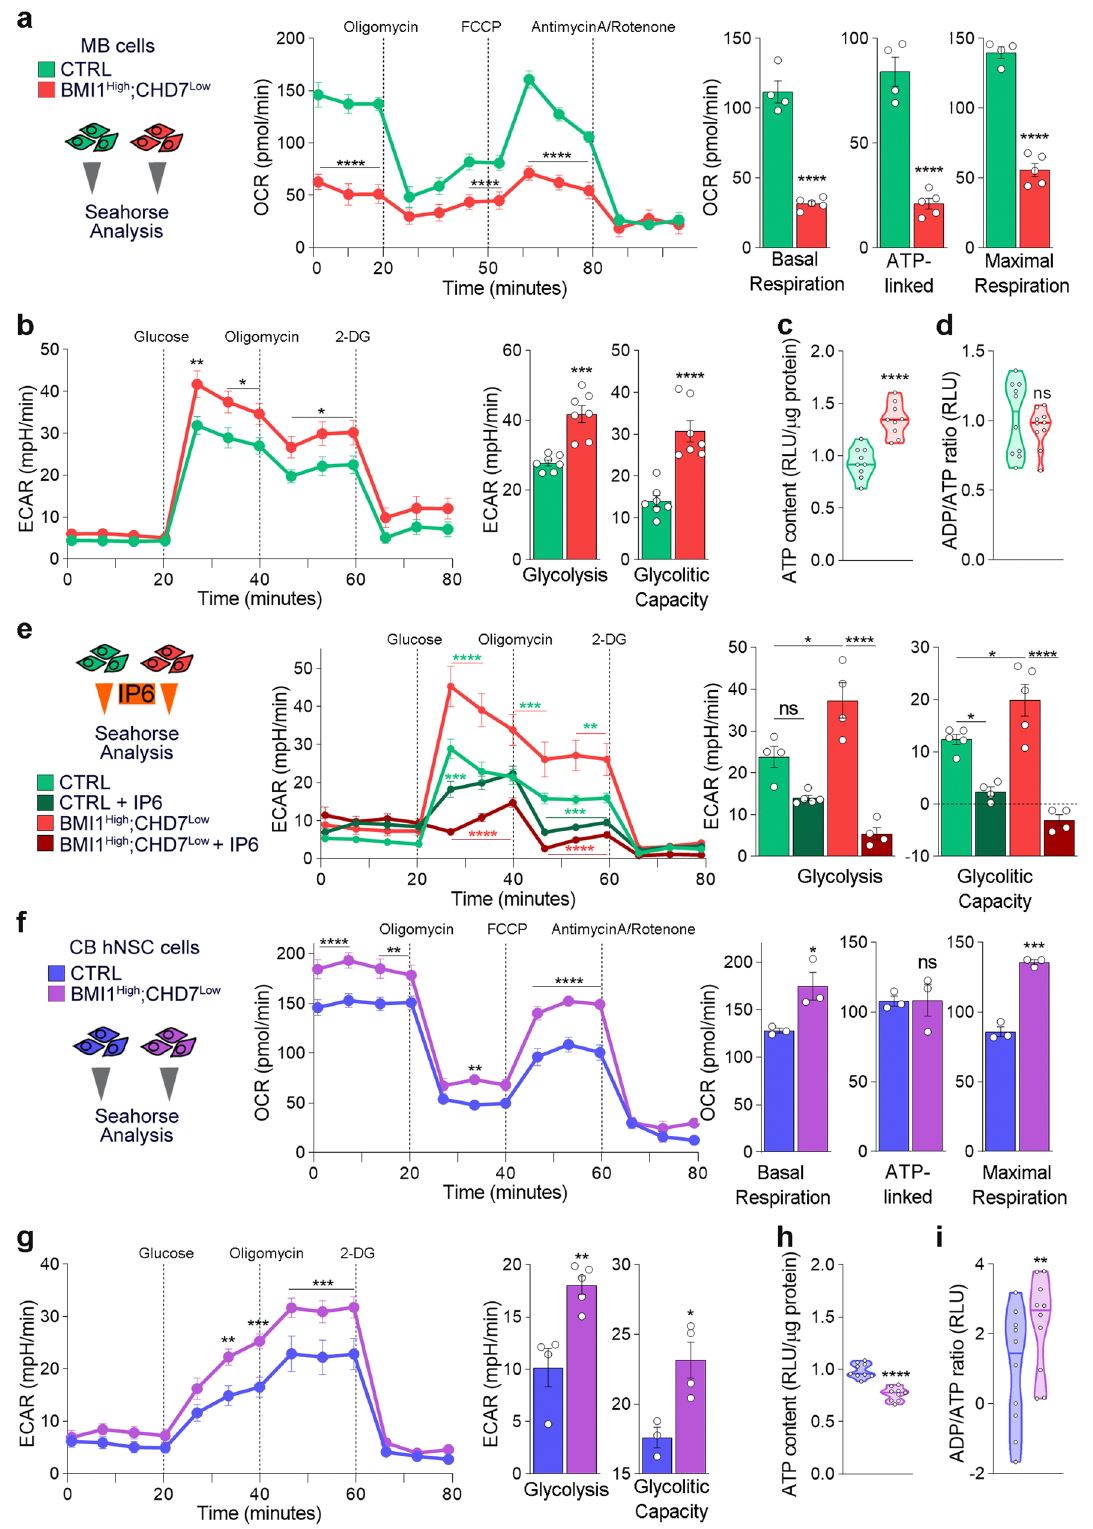
apoptosis was found upon treatment (Supplementary Fig. S4b), suggesting a cytostatic rather than a cytotoxic effect mediated by IP6. In contrast, treatment of hNSC with or without the signature did not affect cell viability (Fig. 4c), raising the possibility that IP6 could be a novel signature-speci fi c treatment for MB with a very low toxicity on the surrounding developing